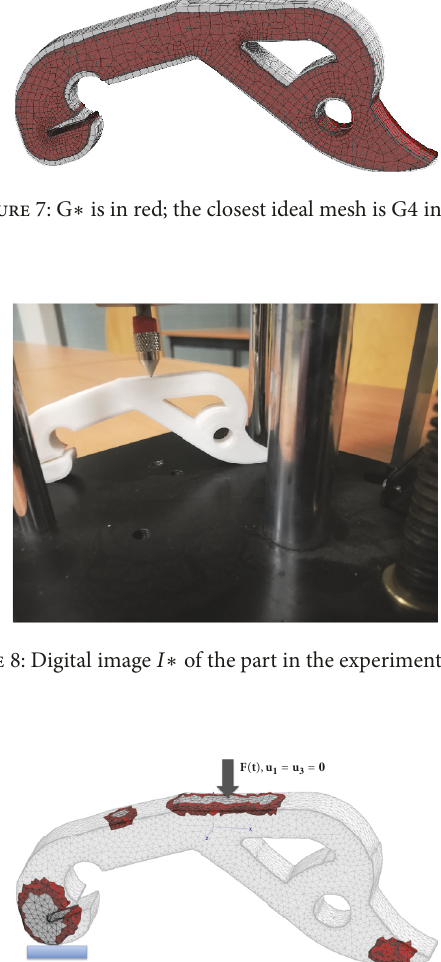
u  =  u  =  Figure 9: A transparency effect has been added to the full mesh 𝐺∗ . Both dark grey and red finite elementsare in the reduced mesh G R ∗ . The grey elements are connected to degrees of freedom in the set P related to the hybrid approximation.